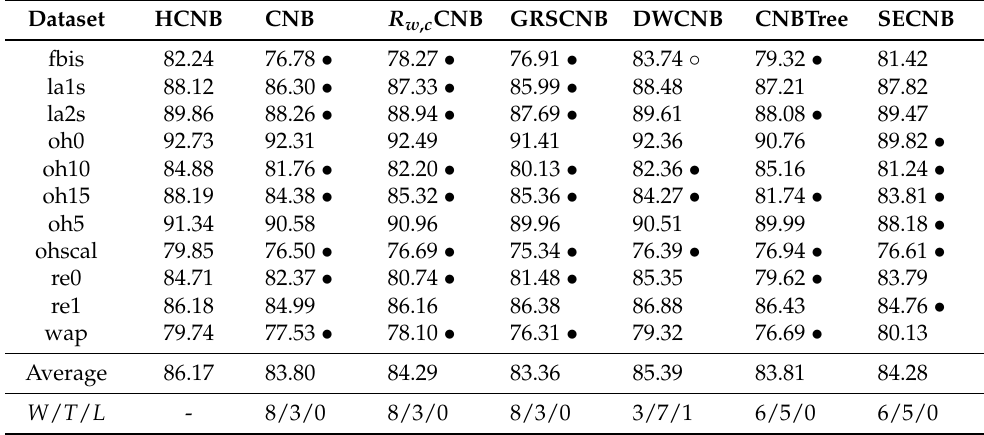
Table 3. Comparisons of the classification accuracy for HCNB vs. CNB, R w , c CNB, GRSCNB, DWCNB, CNBTree, and